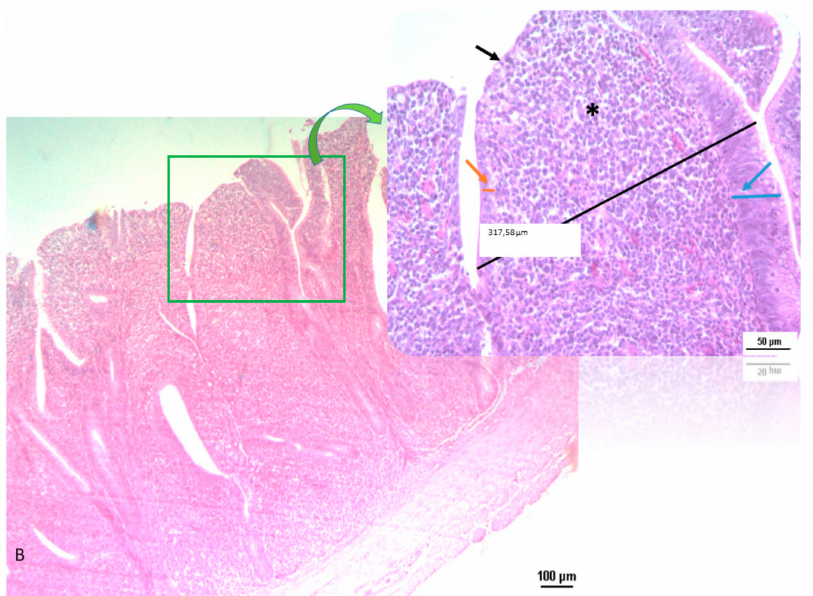
Figure 2. Histological section of BD chicken gut (5 × , 20 × magnification). In the BD group, villi resulted merged with loss of typical epithelium. In the central area (*), the villus is represented by a monocyte infiltrate; the columnar epithelium is degenerated with some area thinned (orange arrow) and others completely lost (black arrow) or thickened (blue